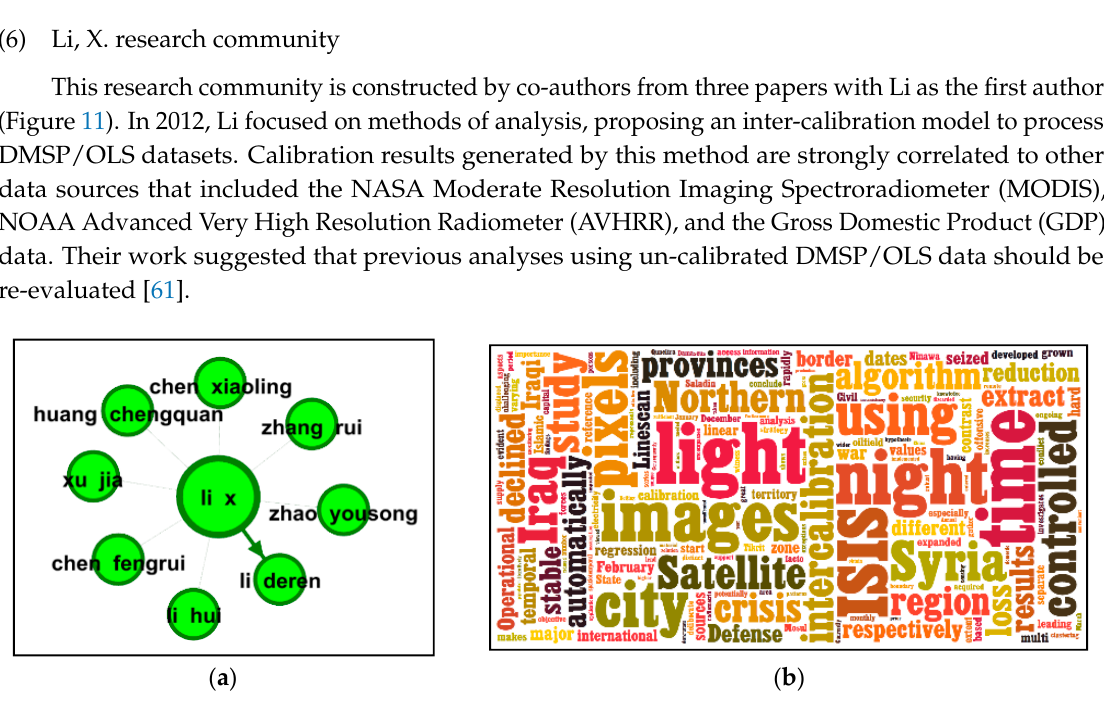
Figure 11. Li, X. research community: ( a ) co-author network; ( b ) related topics.